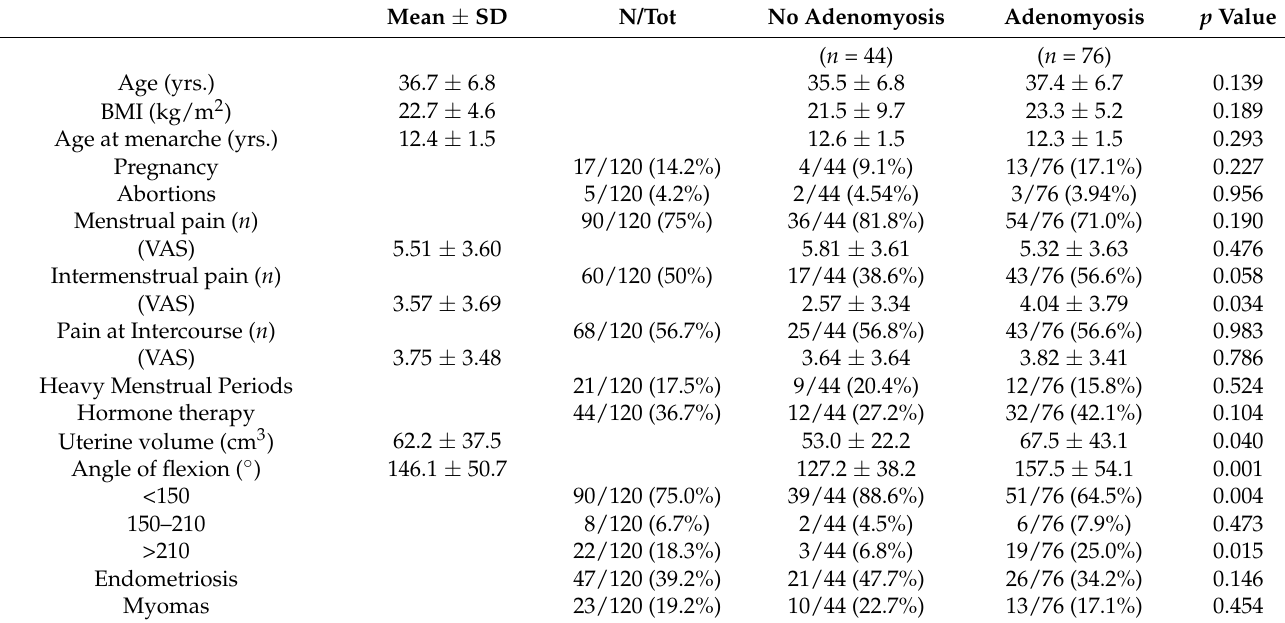
Table 1. Characteristics of patients included in the study. Mean ± SD